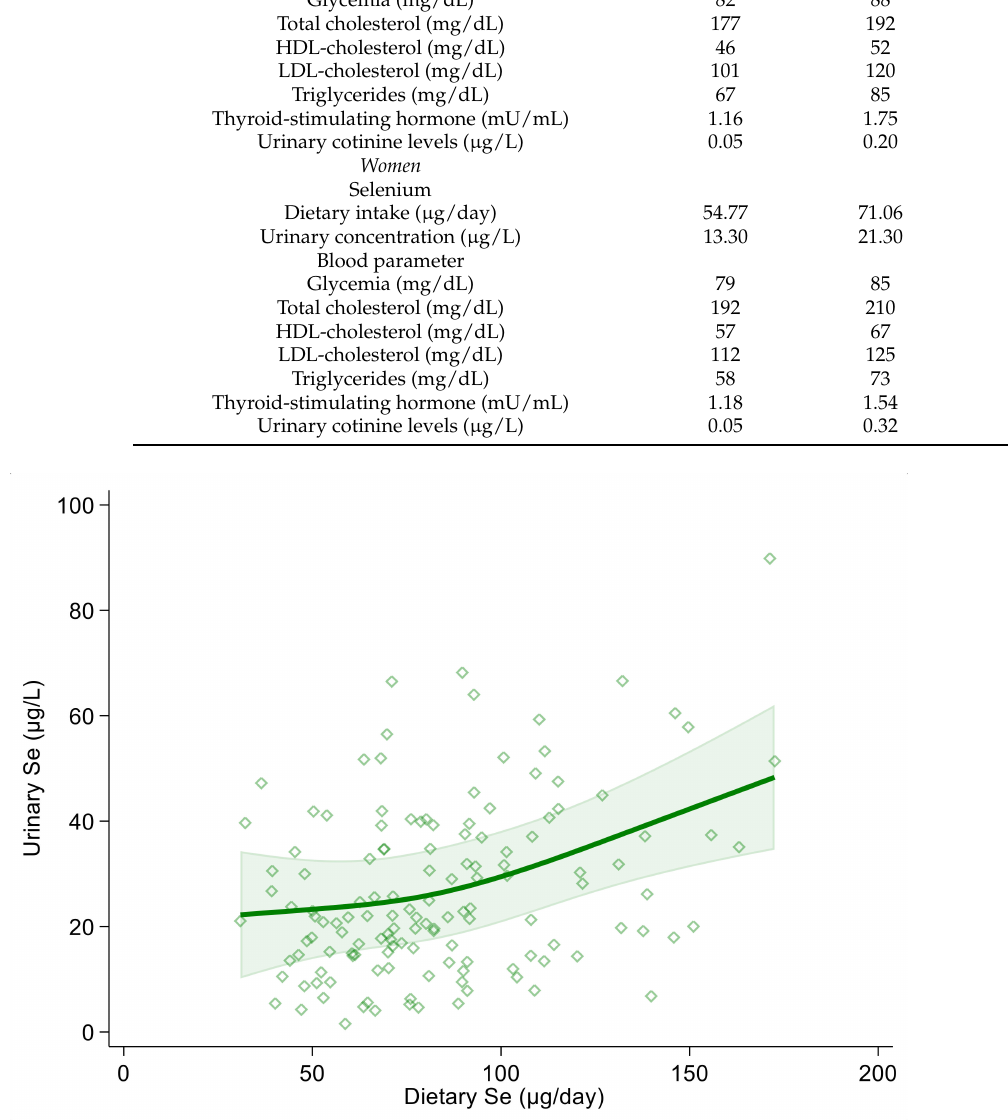
Figure 1. Spline regression analysis of urinary and dietary selenium (Se) levels. Solid line represents multivariable analysis (adjusted for age, sex, body mass index, cotinine levels and alcohol intake) and shaded area indicates upper and lower confidence interval